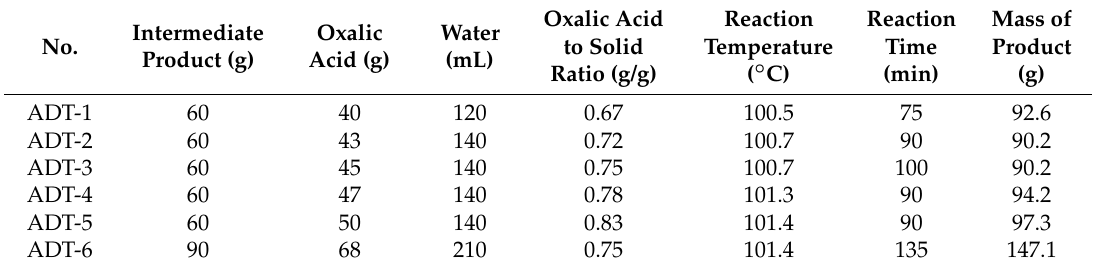
Table 4. Experiment condition of low temperature detoxification